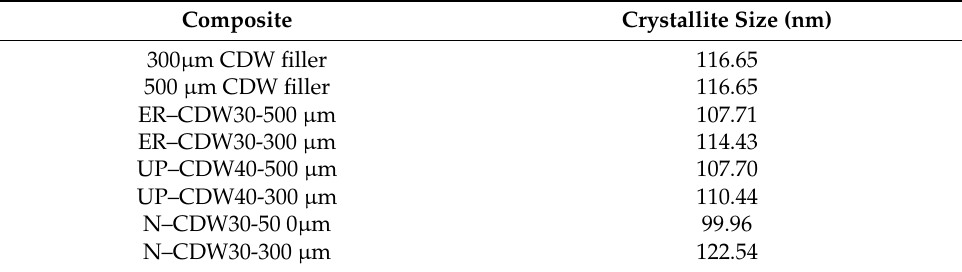
Table 7. Crystallite sizes of fillers and resulting